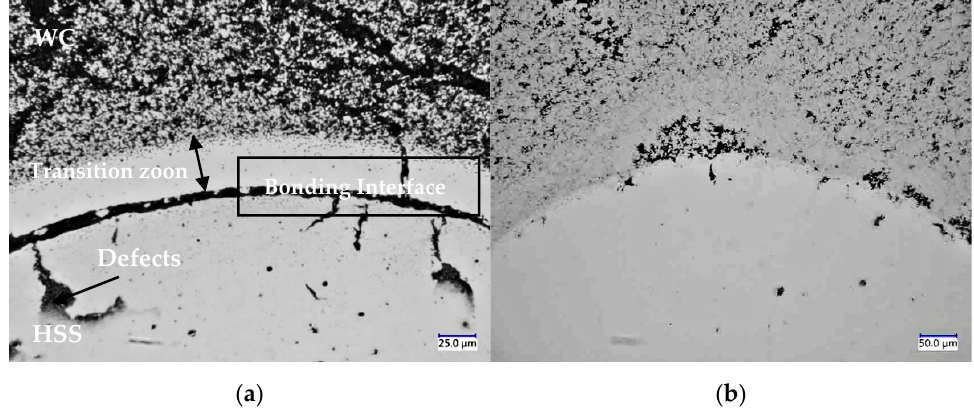
Figure 4. 1300 °C composite interface comparison (OM); ( a ) No Ni added ( b ) Ni added. Figure 4. 1300 ◦ C composite interface comparison (OM); ( a ) No Ni added ( b ) Ni added.